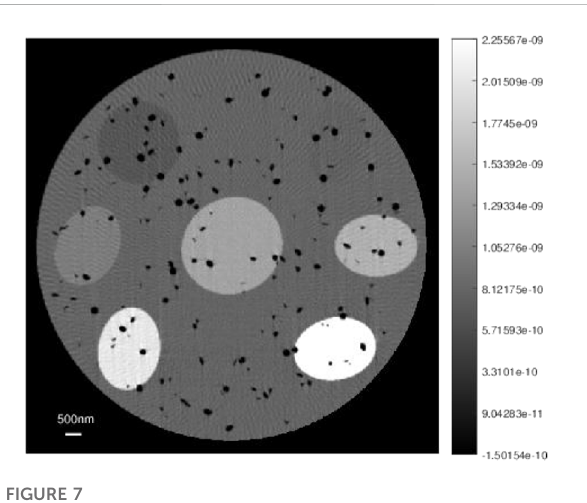
FIGURE 7 The inversion result using PRM for noiseless